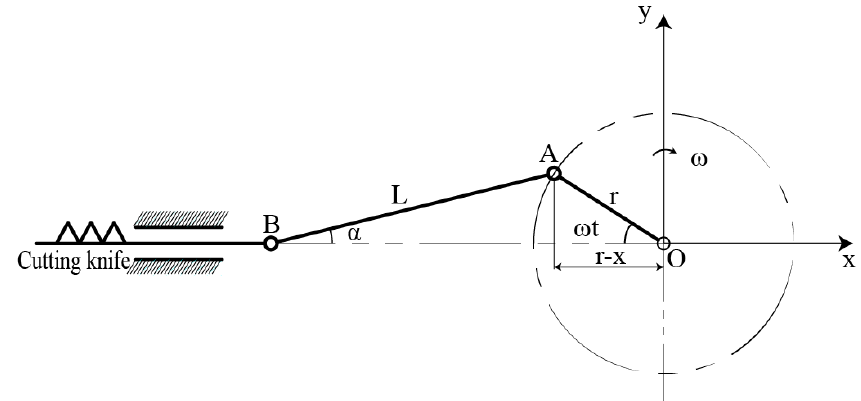
Figure 7. Crank-link mechanism and cutting knife kinematic